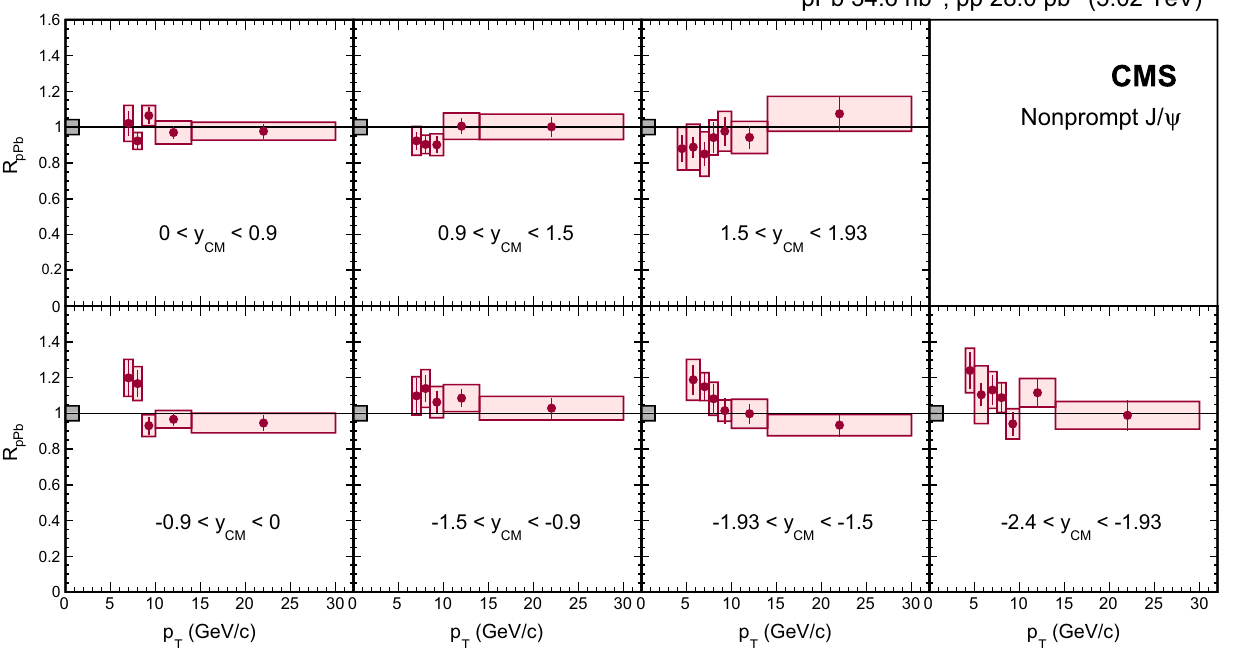
tainties. The fully correlated global uncertainty of 4.2% is displayed as a gray box at R pPb = 1 next to the left